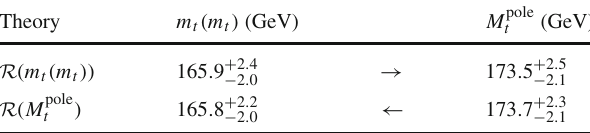
Table 2 Top-quark mass extracted in the pole mass scheme and con- verted to the running mass scheme and vice versa